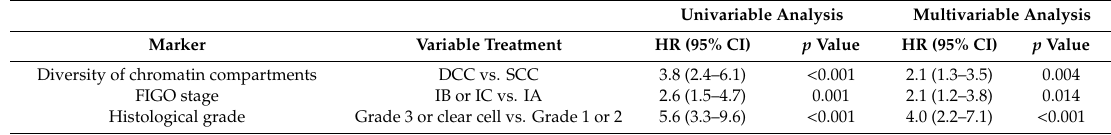
Table 2. Analyses of time to recurrence for patients with ovarian carcinoma.